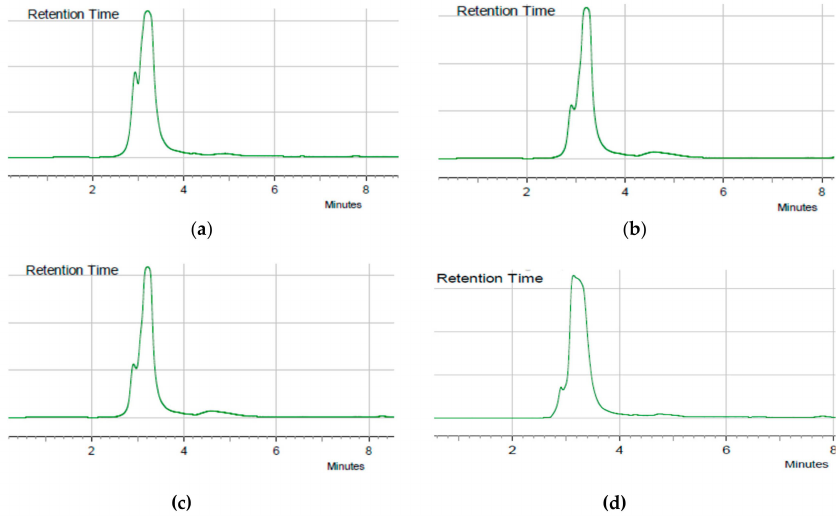
Figure 1. HPLC Chromatograms of extracts from Aspergillus flavus strain isolated from ( a ) Catharanthus roseus, ( b ) Annona squamosa, ( c ) Curcuma xanthoriza, and ( d ) Isolated kojic acid ( 1